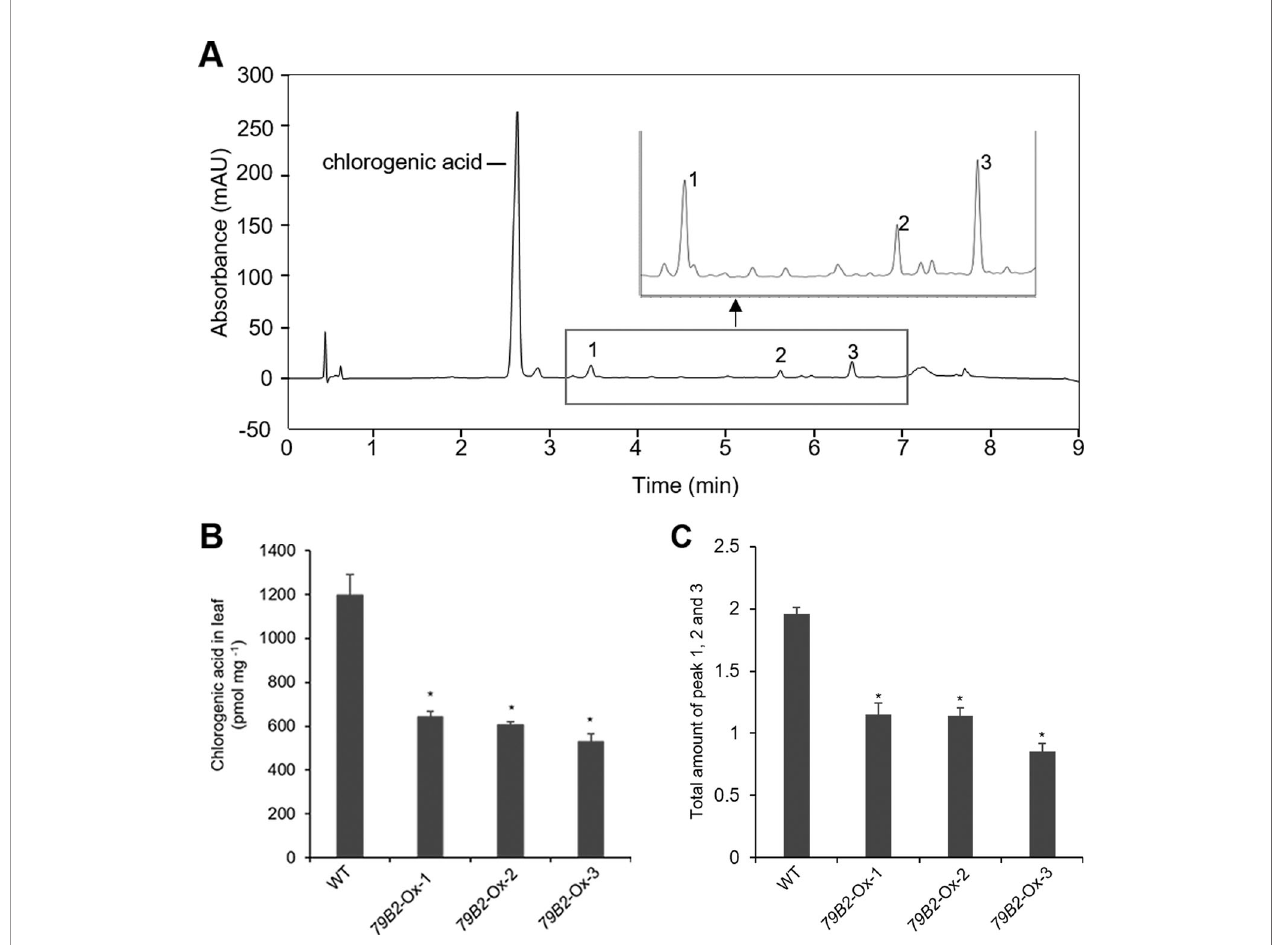
FIGURE 3 | Overexpression of AtCYP79B2 inhibits phenylpropanoid production in Camelina.Representative chromatogram of soluble metabolites in wild-type Camelina leaves is shown (A) . The extract gave four recognizable peaks at 325 nm and chlorogenic acid is a major peak. The inset shows three peaks eluted between 3 and 7 min. Chlorogenic acid contents (B) and the total sum of peak 1, 2, and 3 (C) of the AtCYP79 overexpression lines compared with wild type are shown. Leaf samples were collected from 2-week-old soil grown plants. The total amount of peak 1 to 3 was calculated based on the peak area of each peak. In (B) and (C) , data represent mean ± SE of three independent experiments. * represents P < 0.05 (two-tailed student ’ s t-test) when compared with wild